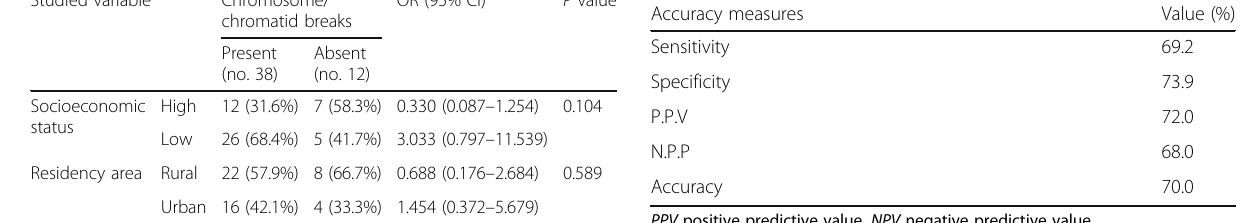
Table 4 The association of socioeconomic status and residency area with chromosome/chromatid breaks in young mothers with history of a DS child Studied variable